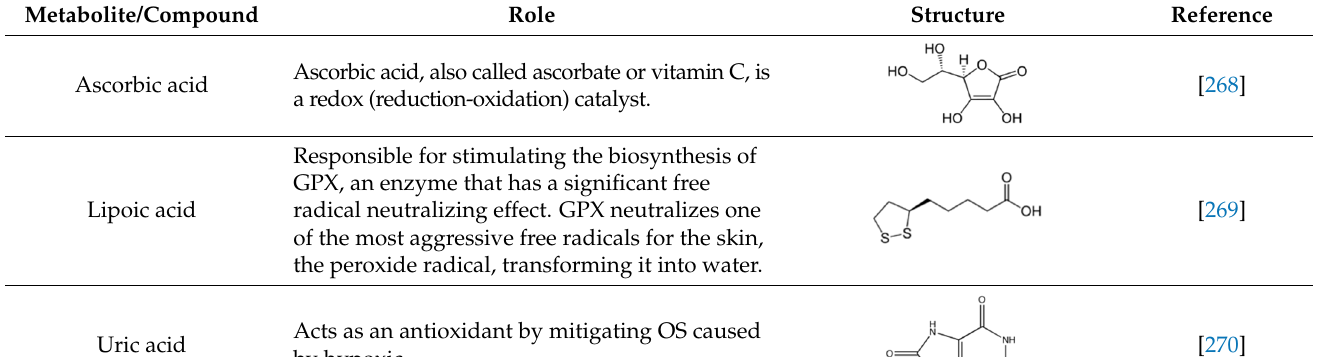
Table 1. Summary of antioxidants, molecules essential for the activity of some antioxidant enzymes and enzymatic systems for reducing oxidative stress (OS).